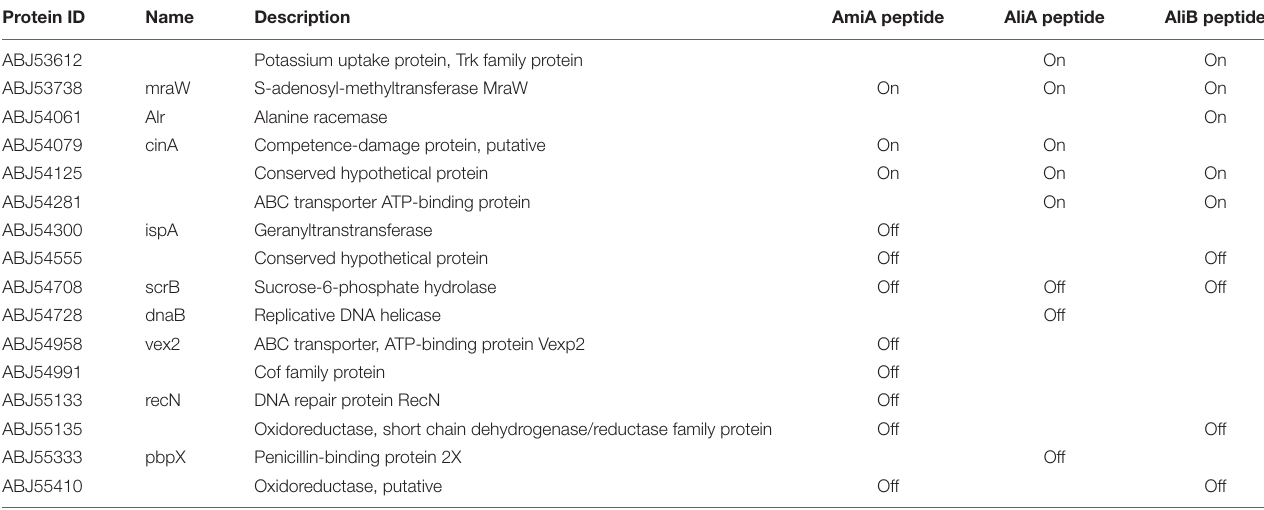
TABLE 1 | All proteins significantly upregulated and downregulated in the wild type strain D39 following a 15 min exposure to each of the peptide ligands ∗ . Protein